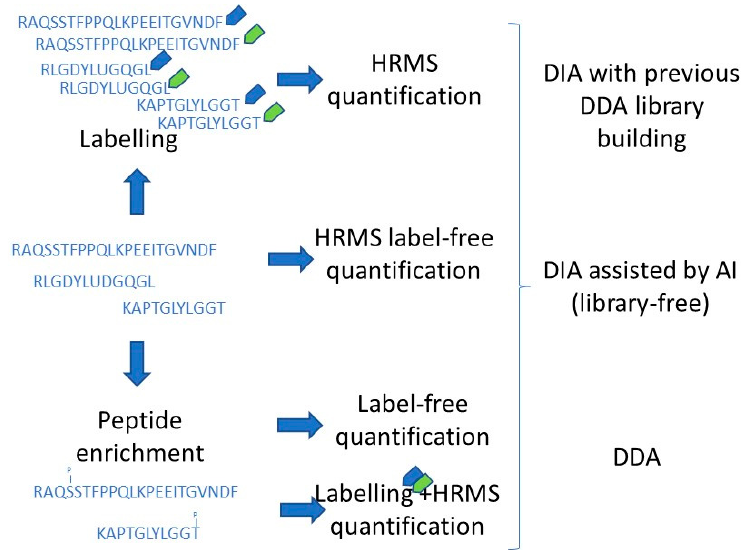
Figure 2. Workflow of labelling and label-free mass spectrometry-based proteomics, as well as peptide enrichment for detecting post-translational modifications. Blue and green tags mean isobaric labelling. HRMS: high resolution mass spectrometry; DIA: data-independent acquisition; DDA: data-dependent acquisition; AI: artificial intelligence.